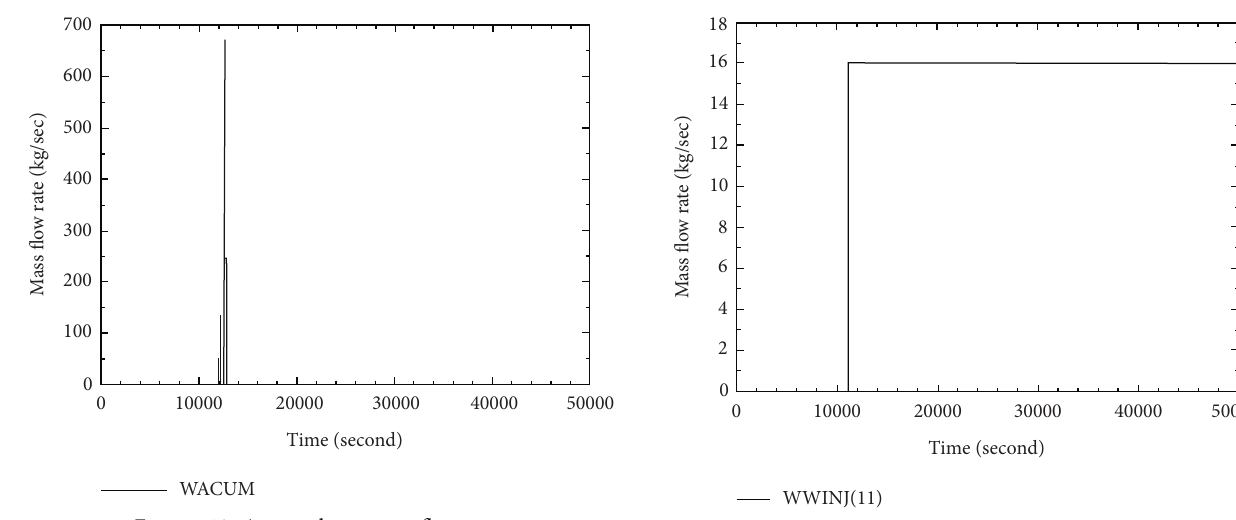
14: External injection mass flow